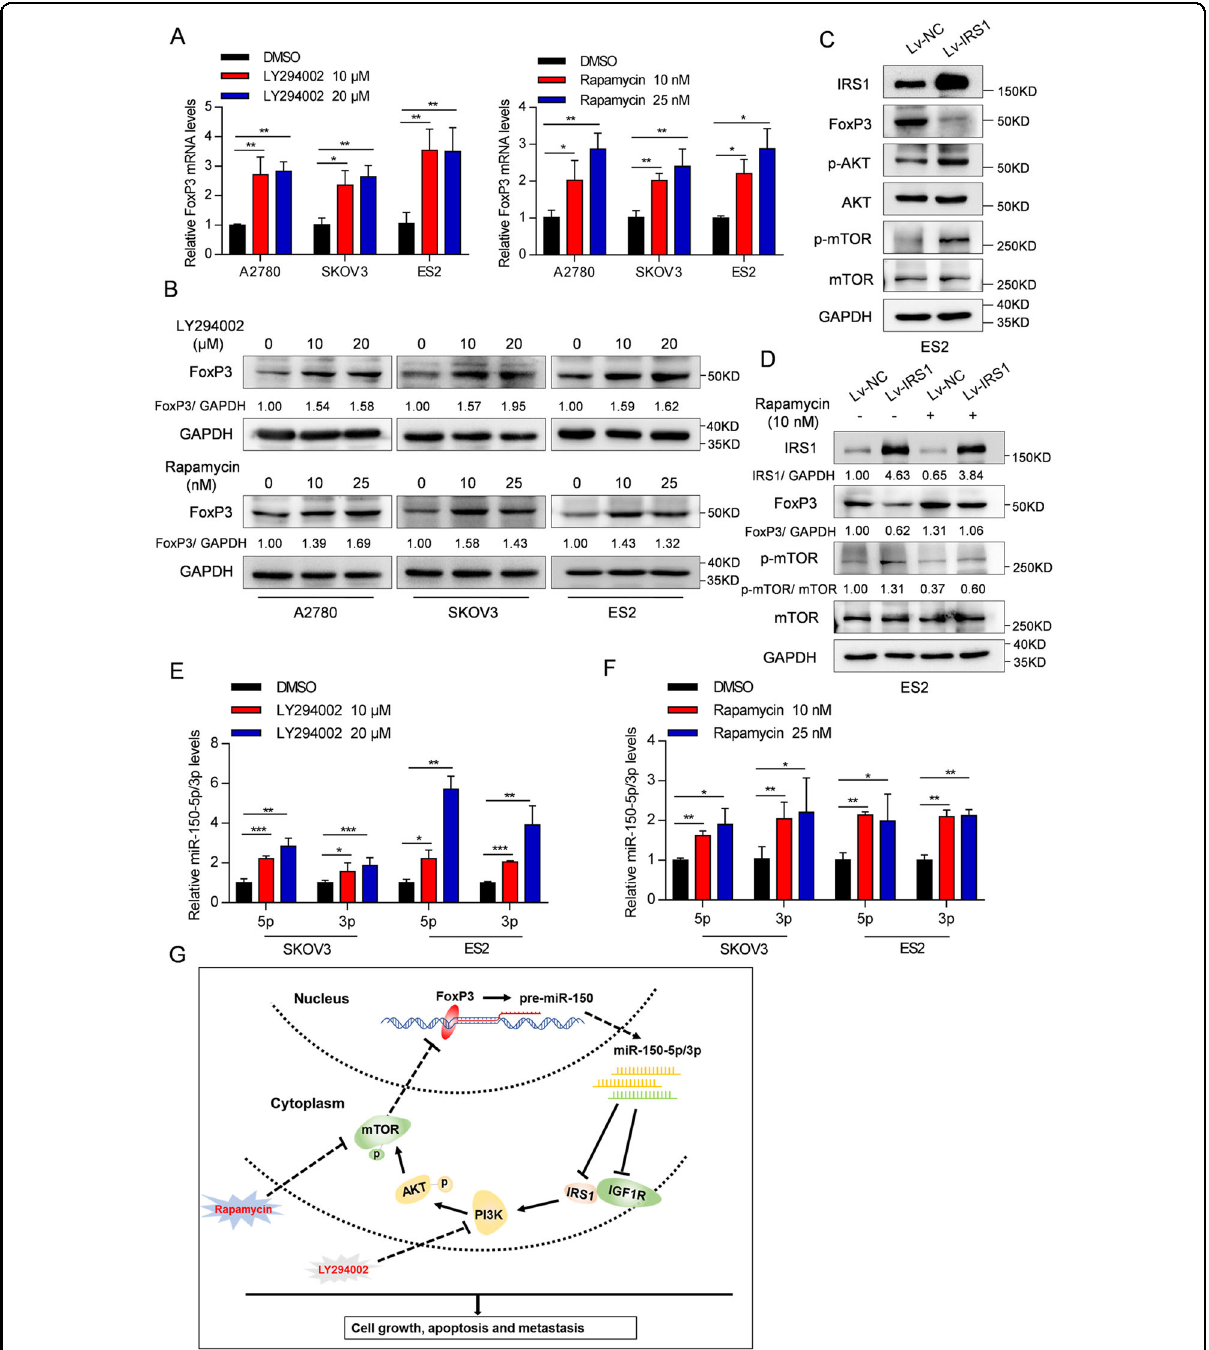
Fig. 7 The PI3K/AKT/mTOR pathway regulates the expression of FoxP3 and miR-150-5p/3p. A , B OC cells were treated with PI3K inhibitor (LY294002) or mTOR inhibitor (rapamycin) for 24 h. The mRNA ( A ) and protein ( B ) levels of FoxP3 were measured by real-time RT-PCR and western blot analyses, respectively. C The protein levels of IRS1, phosphorylated AKT (Ser473), total AKT, phosphorylated mTOR (Ser2448), total mTOR, and FoxP3 in Lv-IRS1-ES2 cells were determined by western blotting. D The protein expression levels of IRS1, FoxP3, phosphorylated mTOR (Ser2448), and total mTOR were measured in Lv-IRS1-ES2 cells treated with 10 nM rapamycin for 24 h. E , F The relative levels of miR-150-5p and miR-150-3p in SKOV3 and ES2 cells treated with LY294002 ( E ) or rapamycin ( F ). The data are presented as the mean ± s.d. * P < 0.05, ** P < 0.01, *** P < 0.001 by Student ’ s t - test. G Schematic diagram of a feedback loop formed from the FoxP3-miR-150-IGF1R/IRS1 axis and PI3K/AKT/mTOR signaling pathway, and its function in OC